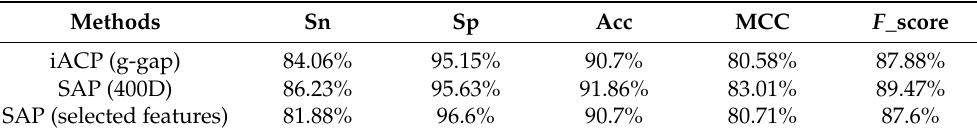
Table 2. Performance comparison with selected